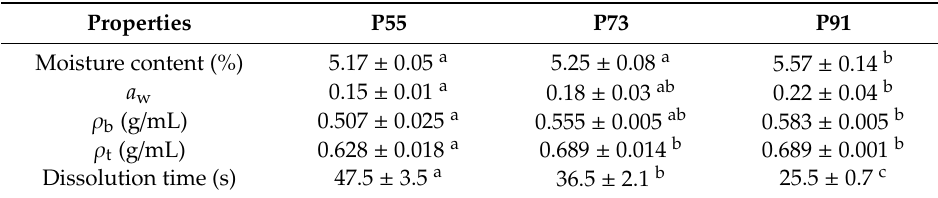
Table 2. Physicochemical properties of spray-dried noni juice